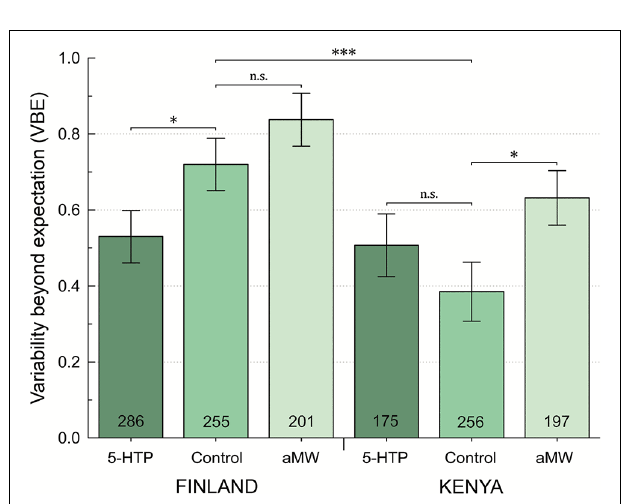
FIGURE 2 | Behavioral variability beyond statistical expectation (VBE) by site and pharmacological treatment. On a log2 scale, VBE = 0 indicates no excess variability, and VBE = 1 indicates twice as much variability as would be expected by chance alone. Error bars are ± 1 SE, calculated by bootstrap resampling; n.s. P > 0.05, ∗ P < 0.05, ∗∗∗ P < 0.001 represent one-tailed